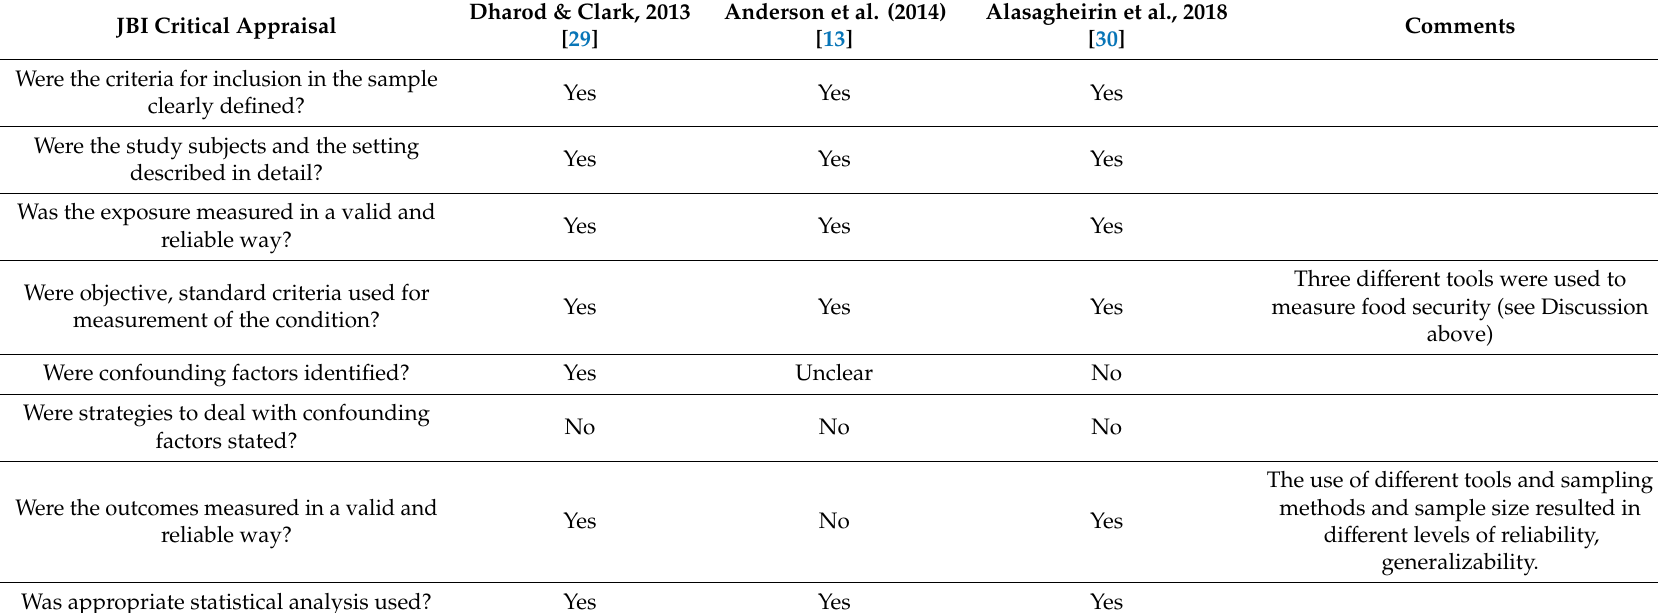
Table A4. JBI Critical Appraisal Checklist for Analytical Cross-Sectional